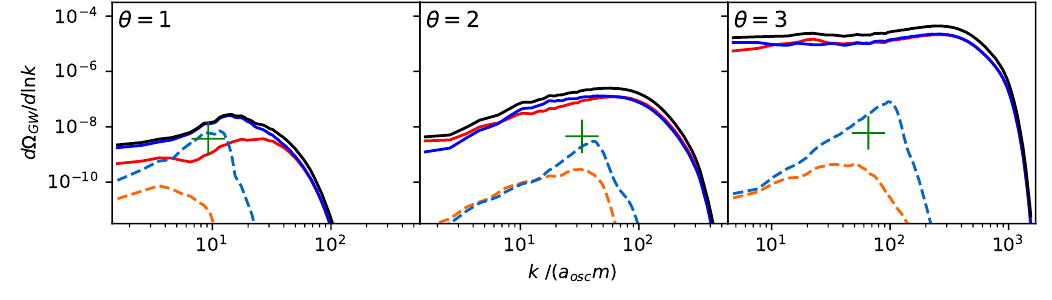
Figure 7: Same as Fig. 6 except α = 40 is held fixed while θ is varied. In the case of θ = 3 we chose a smaller sized box L = π/ ( 3 ma the